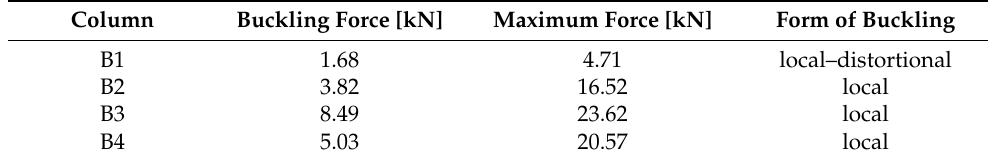
Table 5. Values of buckling forces, maximum forces and buckling modes of columns obtained from the optical method.